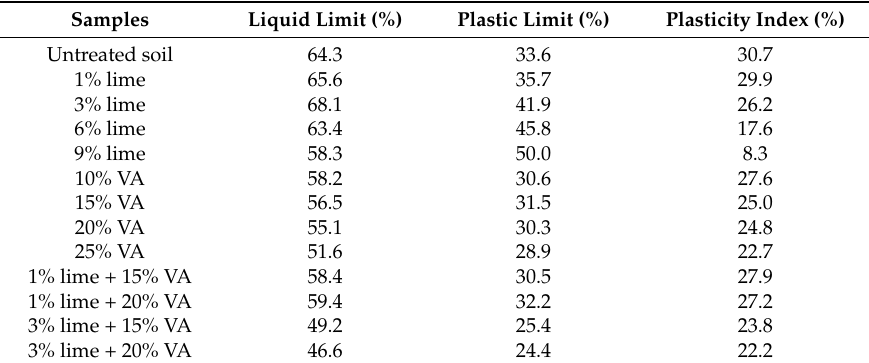
Table 3. Atterberg limits of unstabilized and stabilized BCS.